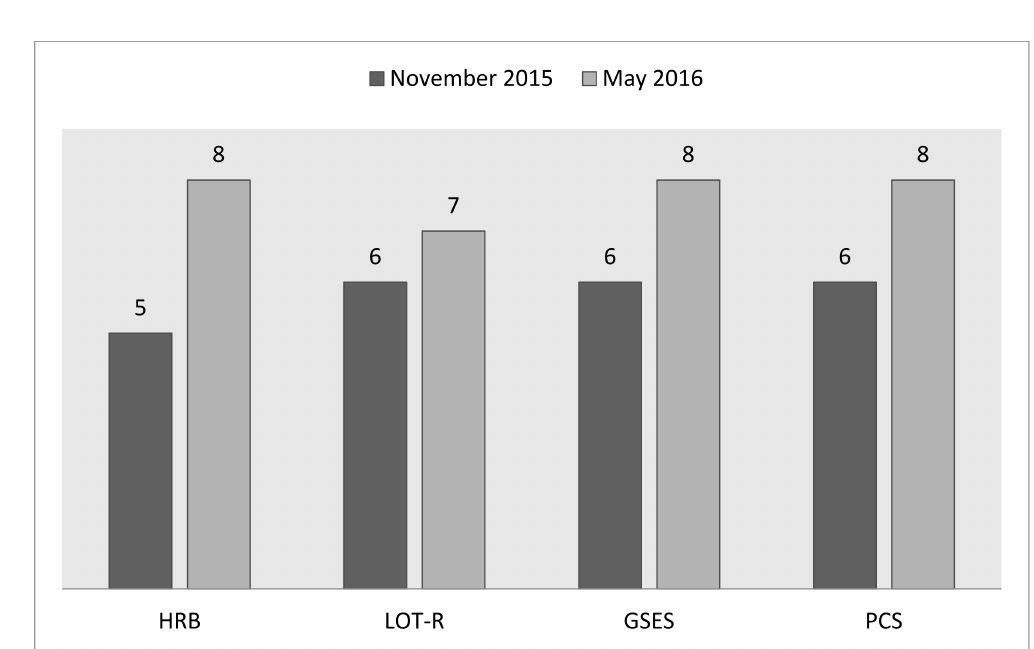
Figure 1. The results from four questionnaires at baseline and at follow-up among patients with chronic mental illness participating in a 6-month psychosocial rehabilitation program, presented as sten